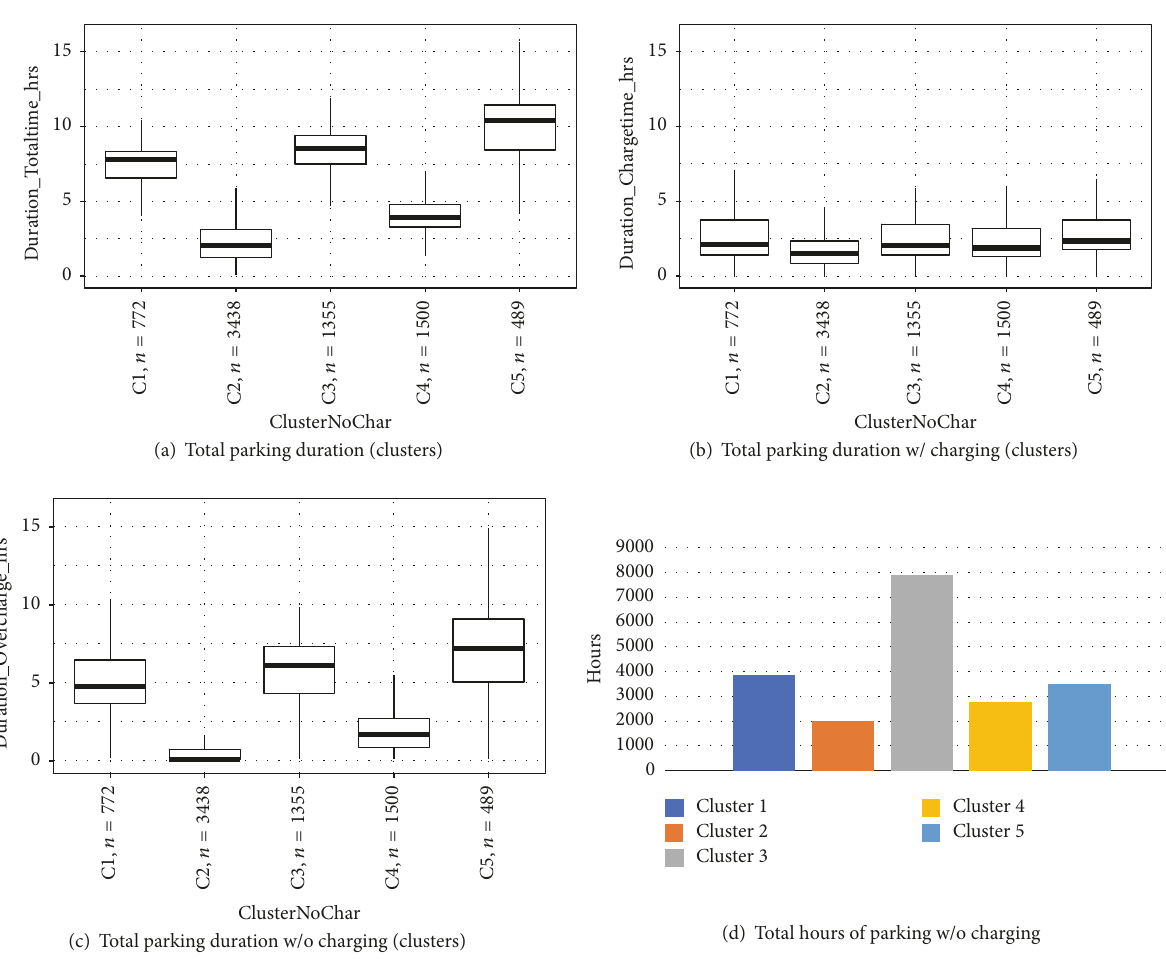
Figure 6: Variation of activities across clusters: (a) parking duration (hours), (b) parking duration with charging (hours), (c) parking duration without charging (hours), and (d) total (i.e., sum of all the daily patterns in the respective cluster). Hours of parking without charging across